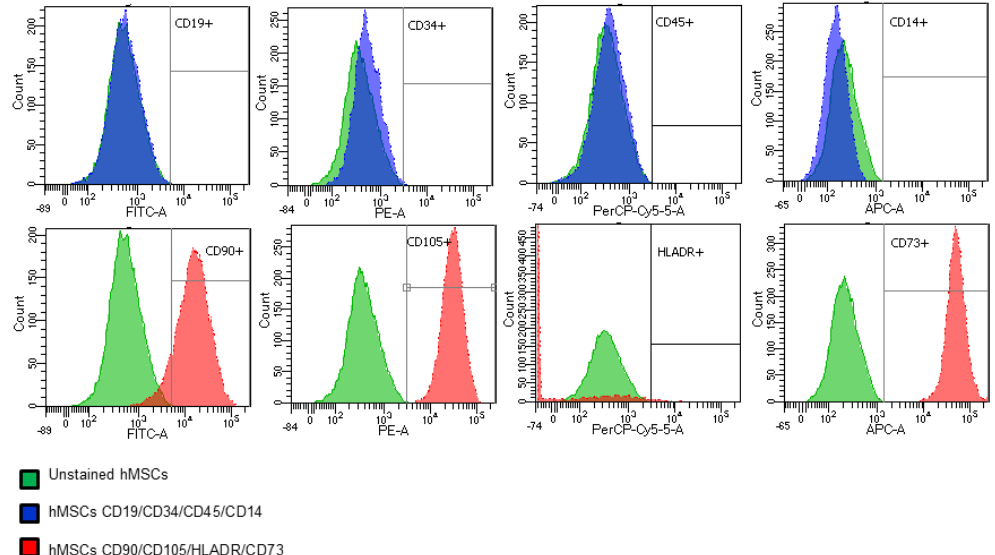
Table 1. Percentage of expression of unstained and stained hMSCs surface proteins and number of events analyzed. Figure 1. Flow cytometry histograms of merged samples of the hMSCs (passage 4) at day 0 of cell culture. Unstained hMSCs ( green ); hMSCs stained with CD19/CD34/CD45/CD14 ( blue ); hMSCs stained with CD90/CD105/HLADR/CD73 ( red ). Fluorescein isothiocyanate (FITC): CD19 and CD90; phycoerythrin (PE): CD34 and CD105; peridinin chlorophyll protein-cyanine5.5 (PerCP-Cy5.5): CD45 and HLA-DR; allophycocyanin (APC): CD14 and CD73.